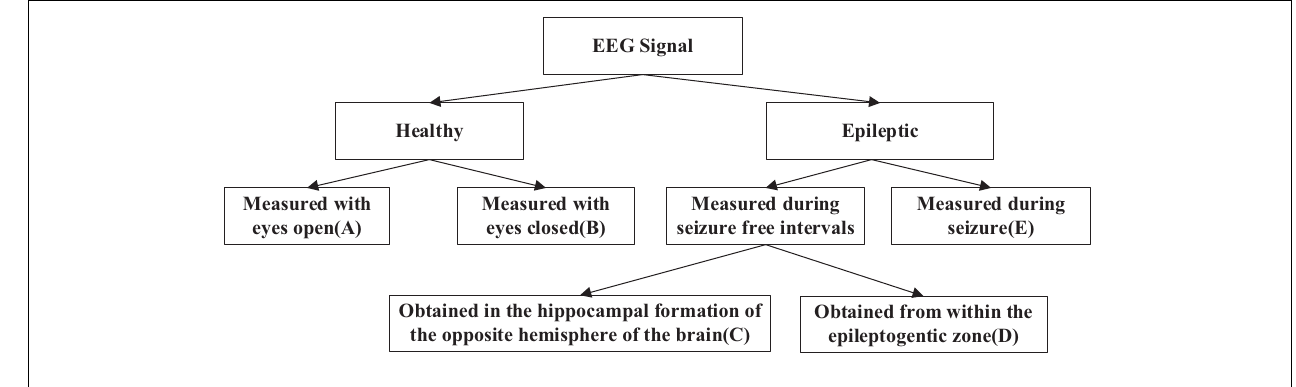
FIGURE 2 | Description of the EEG data.